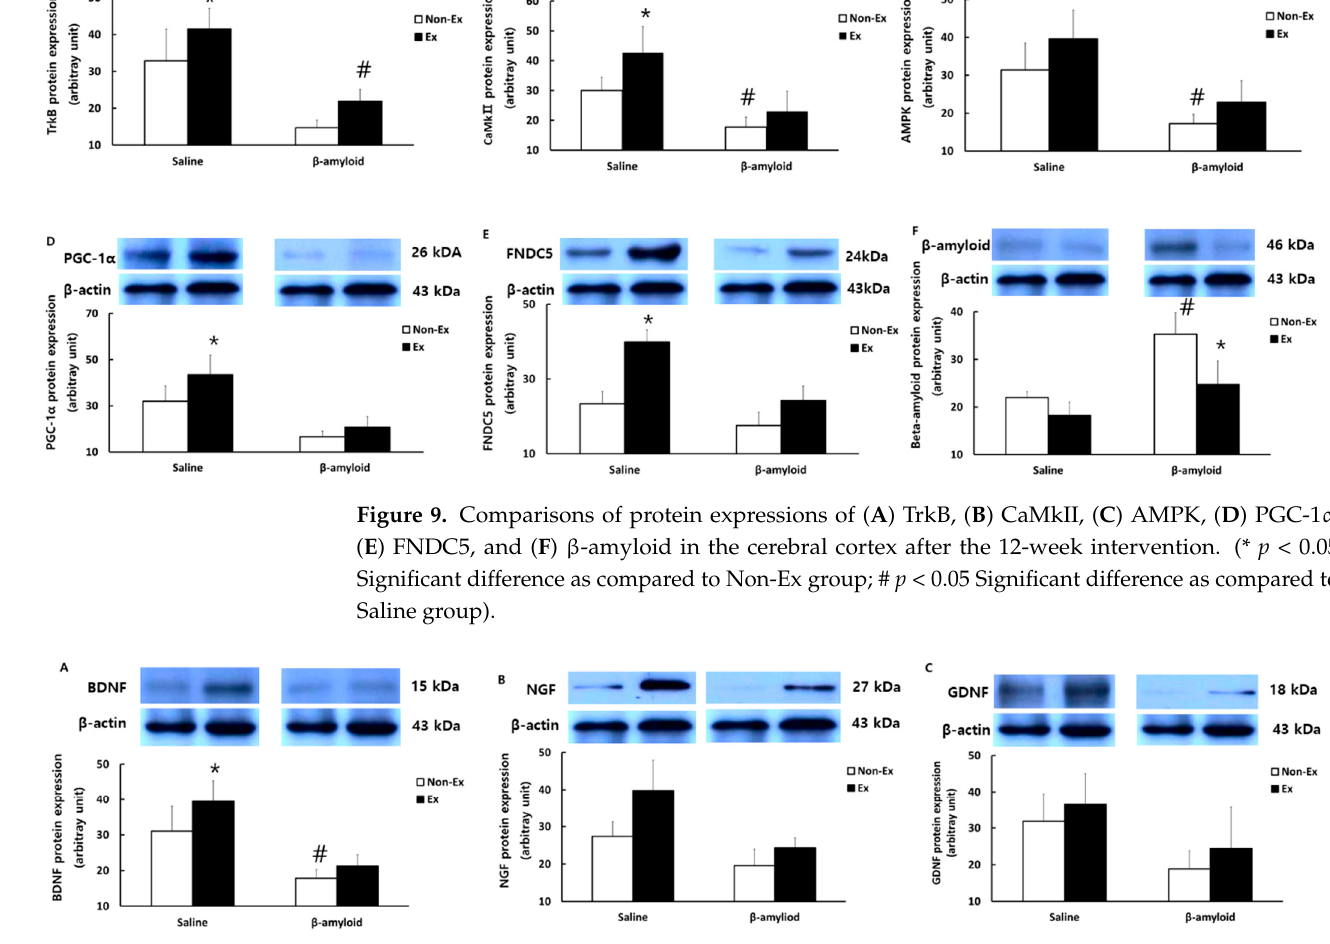
Figure 10. Comparisons of protein expressions of ( A ) BDNF, ( B ) NGF, and ( C ) GDNF in the cerebral cortex after the 12-week intervention. (* p < 0.05 Significant difference as compared to Non-Ex group; # p < 0.05 Significant difference as compared to Saline group).